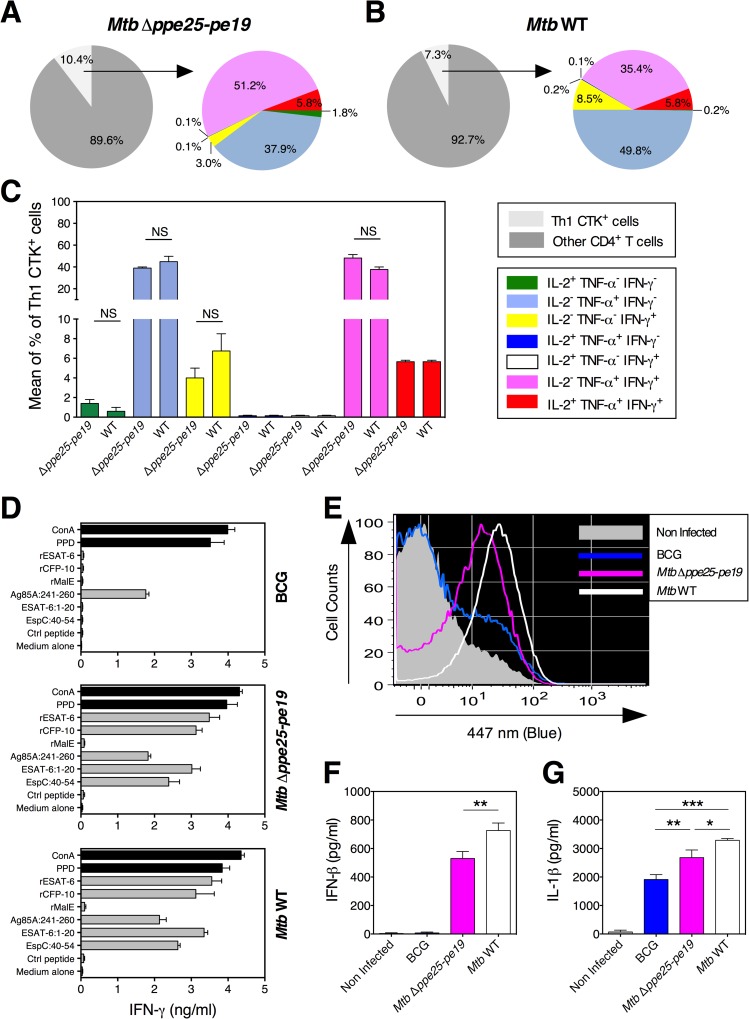
Immunogenic features of the Mtb Δppe25-pe19 strain linked to its functional ESX-1 secretion system.Frequencies of different Th1 cytokine-producing splenic CD4+ T effectors, at 4 weeks p.i., in C57BL/6 mice (n = 5 per group) immunized the Mtb Δppe25-pe19 (A) or the Mtb WT strain (B) and stimulated in vitro with 10 μg/ml of the ESAT-6:1–20 peptide. C) Means ± SD of the frequencies of each Th1 subset, compared between the Mtb Δppe25-pe19- and the Mtb WT-immunized mice. NS = statistically not significant as determined by Mann-Whitney test. The immunized mice were those studied for PE/PPE-specific responses in the Fig 2. D) C57BL/6 mice (n = 2 per group) were immunized s.c. with 1 x 106 CFU/mouse of BCG, Mtb Δppe25-pe19 or Mtb WT strain. At 4 weeks p.i., IFN-γ T-cell responses were studied against ESAT-6, CFP-10 and EspC ESX-1 antigens. EspC:40–54 is an immunodominant I-Ab-restricted epitope that we recently identified by epitope mapping. E) Phagosomal rupture induced in differentiated THP-1 macrophages, infected at MOI of 1, with the Mtb Δppe25-pe19 strain as compared to the Mtb WT and to BCG Pasteur, as determined at day 3 post infection by the CCF-4-based FRET inhibition assay. In parallel, IFN-β (F) and IL-1β (G) were quantified in the culture supernatants of these infected THP-1 cells at 24 h post infection. *, **, *** = statistically significant, as determined by One Way ANOVA test with Tukey’s correction for multiple comparisons, p<0.05, p<0.005 or p<0.001, respectively.